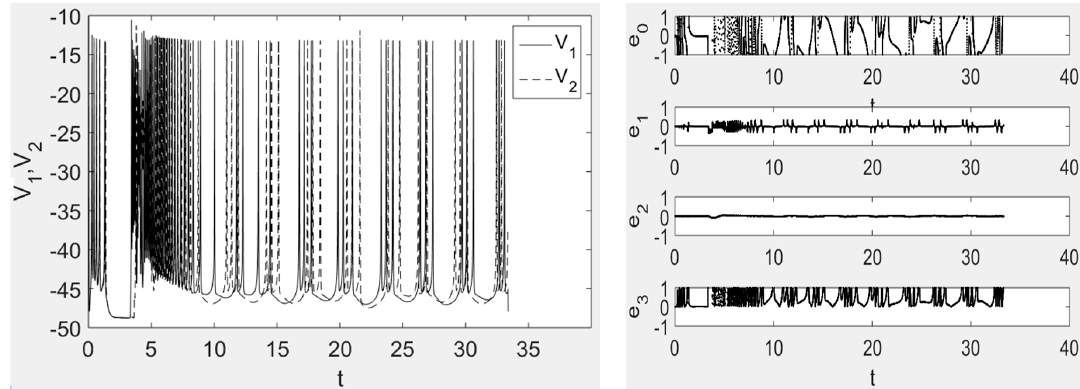
Figure 13. Time histogram and synchronization discrepancy graph when τ = 2.5 and H syn = 5.3.